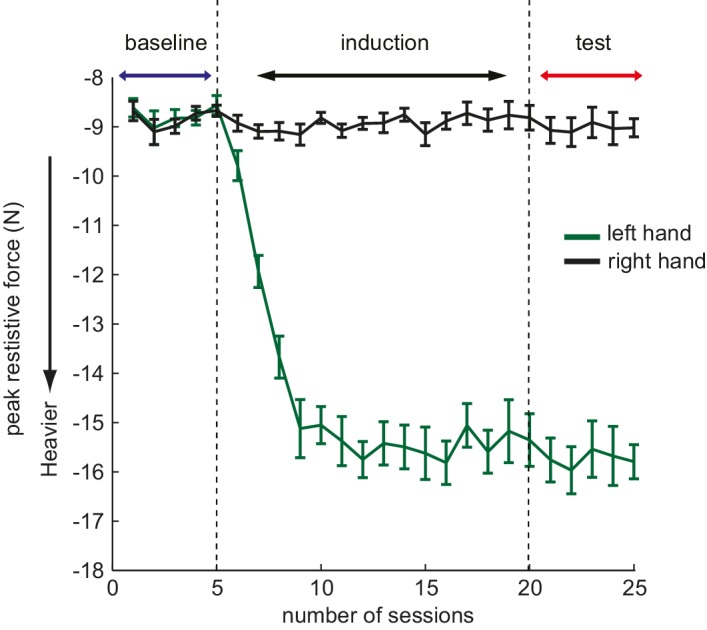
Example of the peak resistive force increase profile in the study.The presented data is force data from Experiment 1, averaged across trials and participants in each session. Here, each session contains 66 trials (33 trials for each left and right) of reaching movements. Since the resistive force is provided in a velocity-dependent manner, the variance is reflecting the variability of the movement velocity across participants.